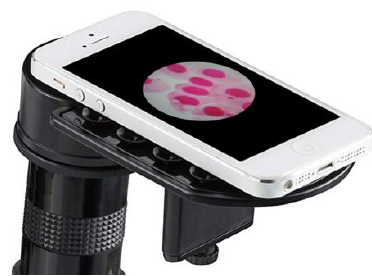
Figure 2 . Microscopic image acquisition with a smartphone and special holder. Figure 2. Microscopic image acquisition with a smartphone and special